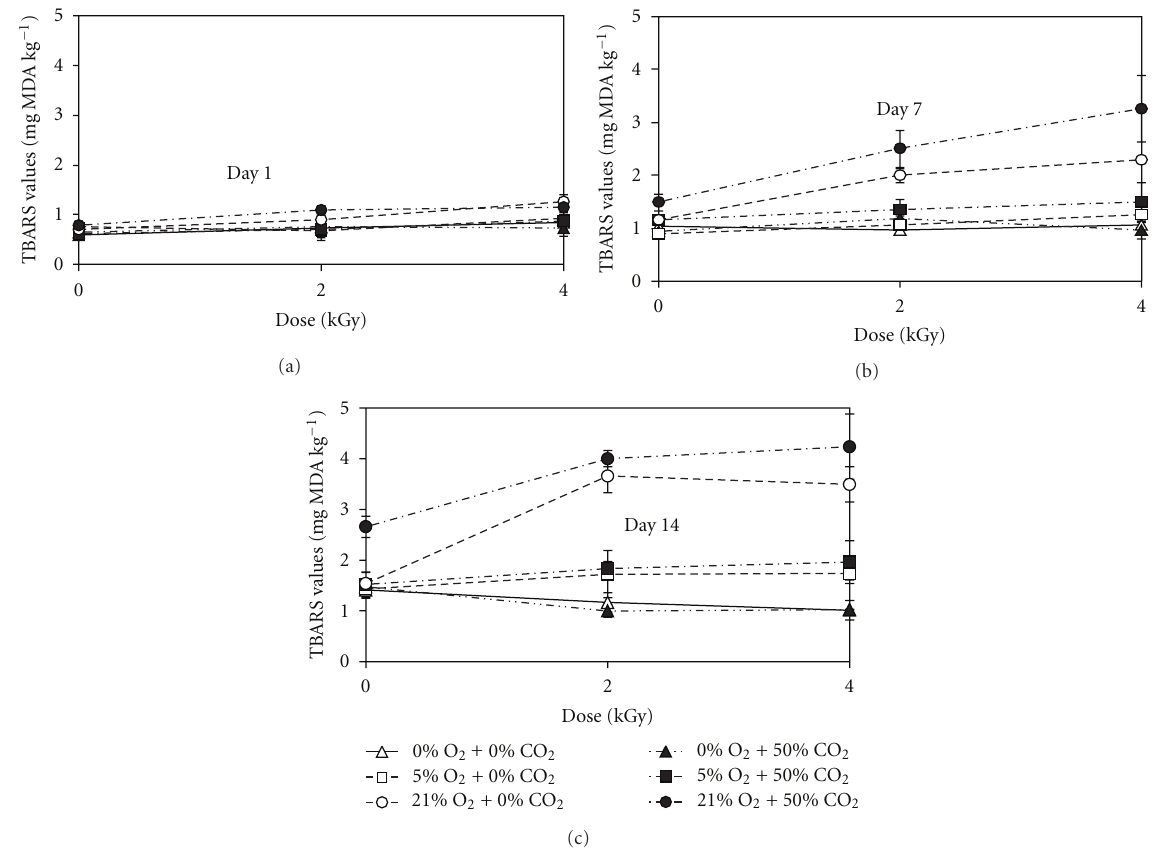
Figure 1: E ff ects of irradiation dose and O 2 and CO 2 levels in packages on TBARS values of ready-to-cook meatballs during storage at 3 ◦ C. Error bars represent standard